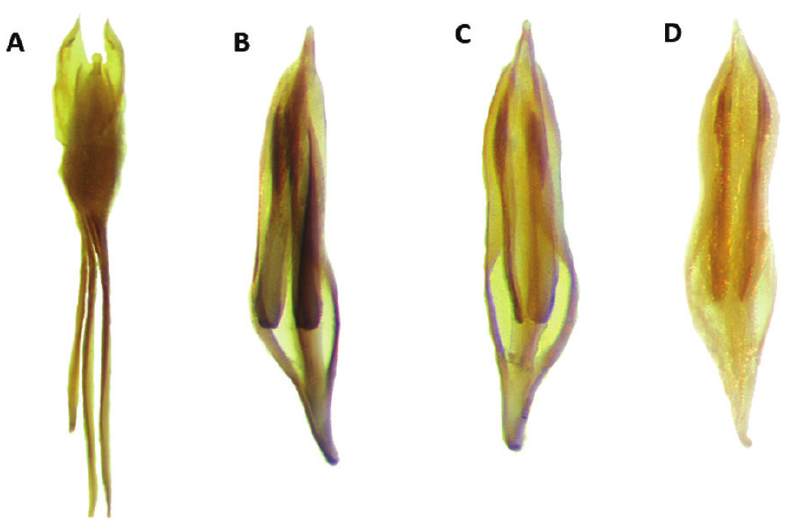
Figure 20. Male genitalia of: A Lecontella striatopunctata B Monophylla californica C Monophylla pallipes D Monophylla terminata